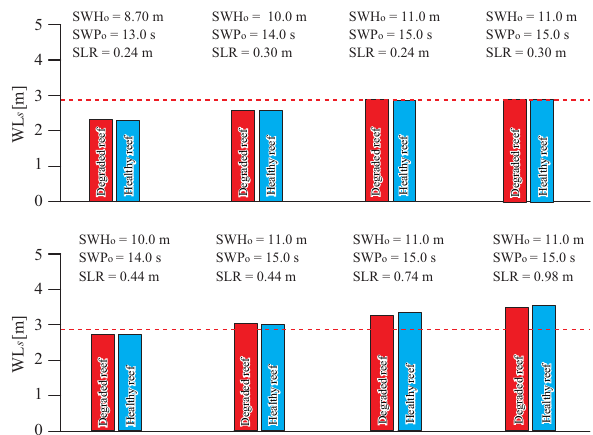
Figure 7. Effect of reef growth on change in the water level at the shore for the TCs by 2100. Assumptions: 8.70–11.0m SWH o ; 13.0– 15.0s SWP o ; 0.24–0.98m SLR; 1.8m above present m.s.l. WL o (i.e., high tide and storm surge). The SLR values are based on the values for the RCP scenario in 2100 (Church et al., 2013). The hor- izontal dashed line shows the elevation of the road ( + 2.86m above present m.s.l.) at the study site. The road will be frequently flooded even if the reef is